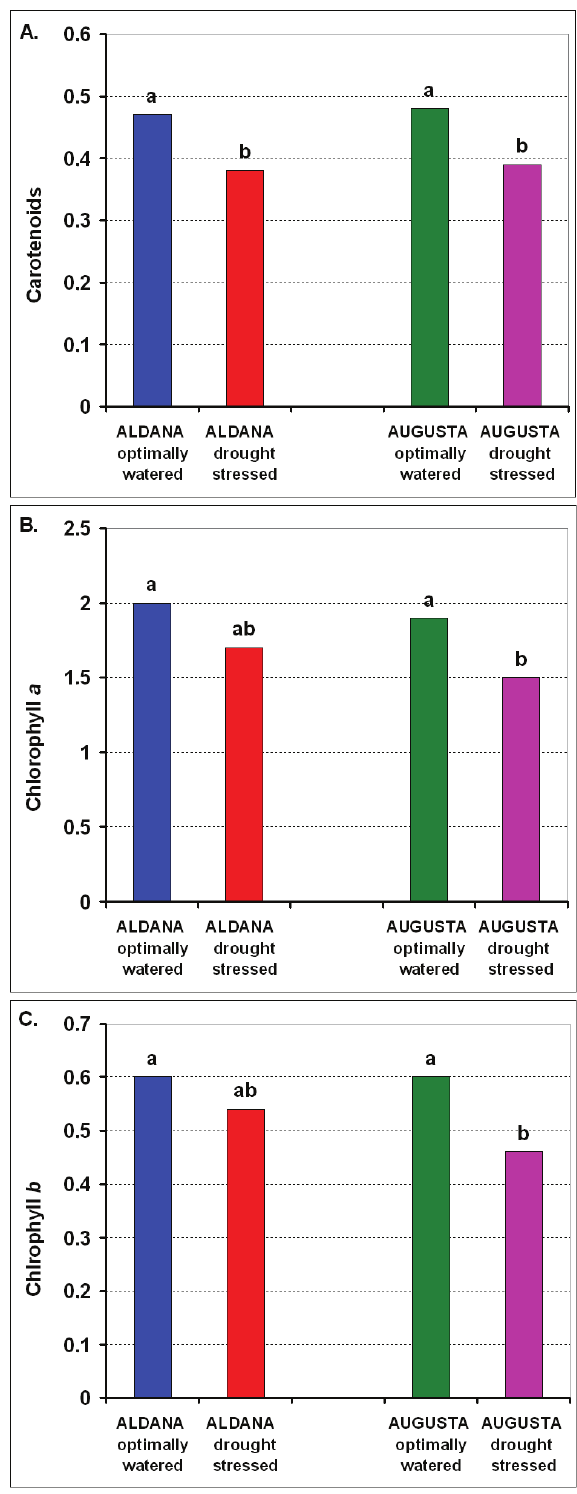
Figure 3: Content of carotenoids (A) and chlorophylls (B and C) [mg g D.W. -1 ] in the leaves of optimally watered and drought-stressed soybean (cv. Aldana and cv. Augusta). Values marked with the same letters (within columns) are not significantly different according to the Duncan’s multiple range test, P <